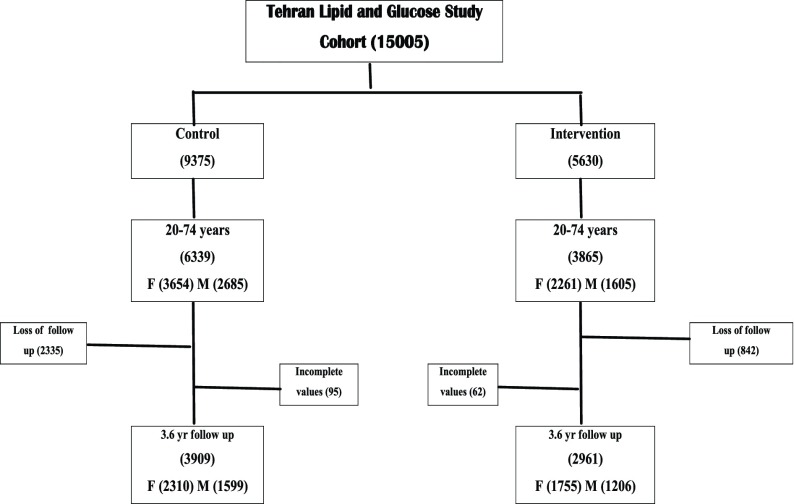
Flow Chart of Control and Intervention Groups.F=Female, M=Men, number in parenthesis denote number of individuals